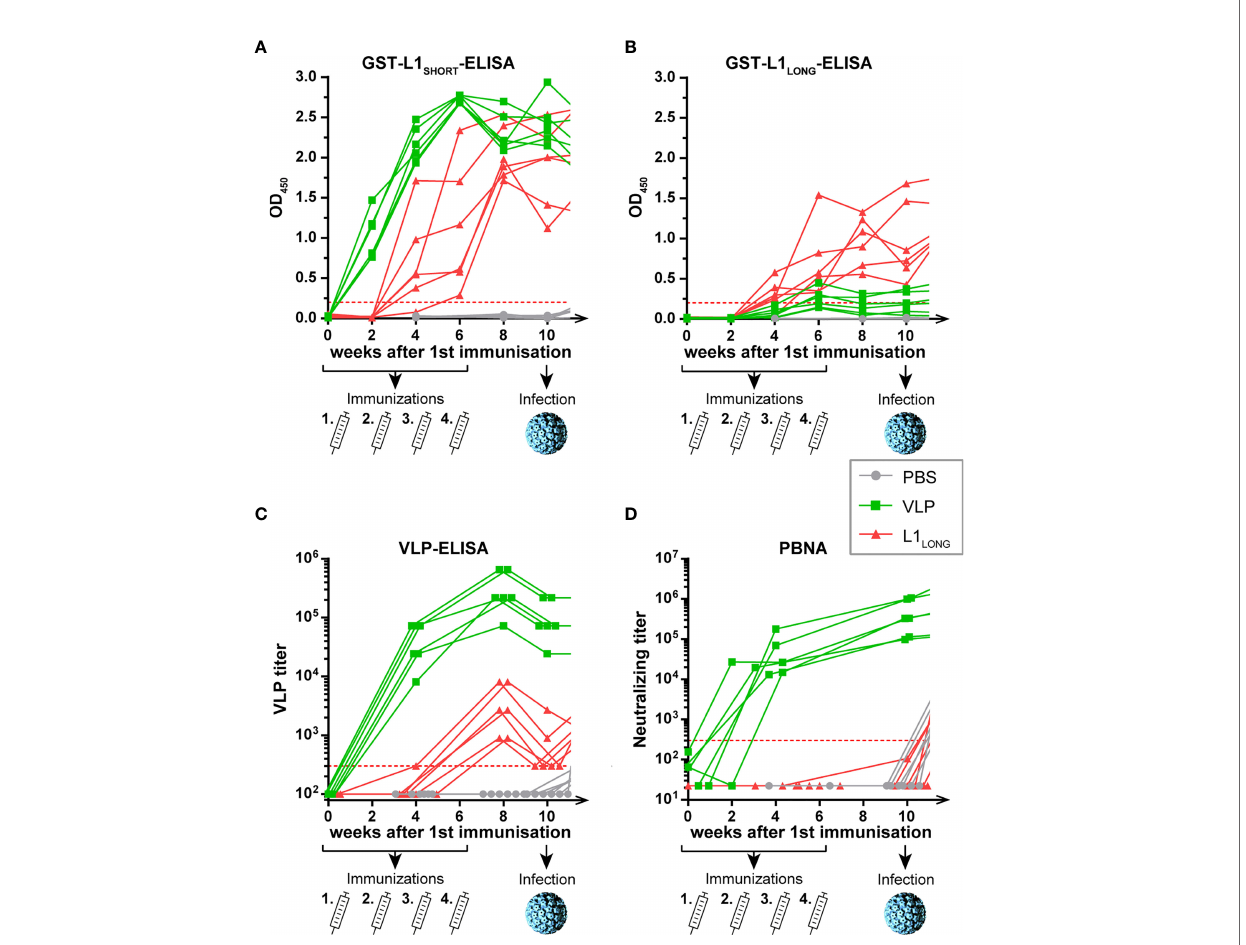
FIGURE 2 | Seroconversion of L1 LONG - and VLP-vaccinated animals. Seroresponses measured by GST-ELISAs against (A) L1 SHORT , (B) L1 LONG , (C) Virus-like- particles (VLP) and (D) in pseudovirion-based neutralization assay (PBNA). The animals were vaccinated four times with MnPV L1 SHORT -derived VLPs (green), MnPV L1 LONG (red) or PBS (grey) in biweekly intervals from weeks 0 to 6 prior to an experimental infection at week 10. Number of animals for each group, n = 6. Dashed lines represent the methods ’ cut-offs (OD 450 = 0.2 for GST-ELISA or titer of 300 for VLP-ELISA and PBNA). Note that the graph is continued in Figure 4